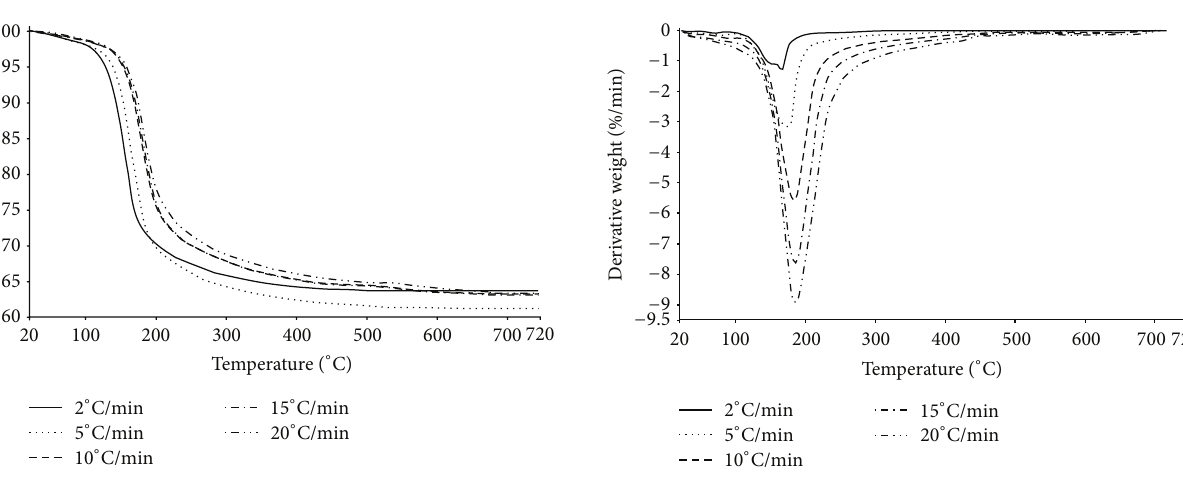
parameters of 𝐸 𝑎 and 𝑘 0 for each heating rate were calculated from the intercept and slopes of the curves, respectively. 𝐸 𝑘 (𝑅 2 ) values obtained 𝑎 , 0 , and the correlation coefficient for each curve are shown in Table 4. The activation energy values were calculated as 47.81– 101.18 kJ/mol and 53.91–103.95 kJ/mol according to